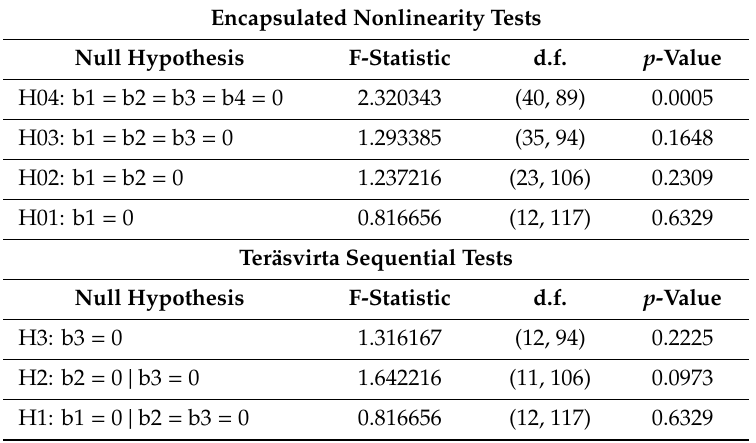
Table 7. Encapsulated nonlinearity